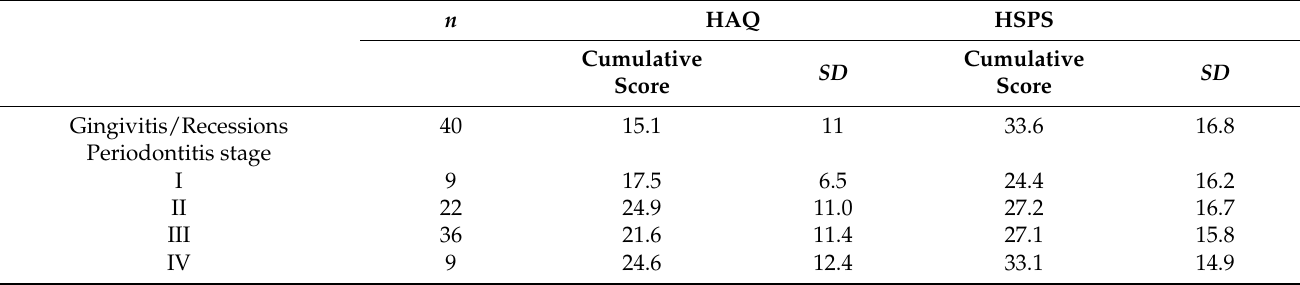
Table 2. Cumulative scores of Hierarchical Anxiety Questionnaire (HAQ) and higher sensory processing sensitivity (HSPS) in the respective stages of periodontitis.